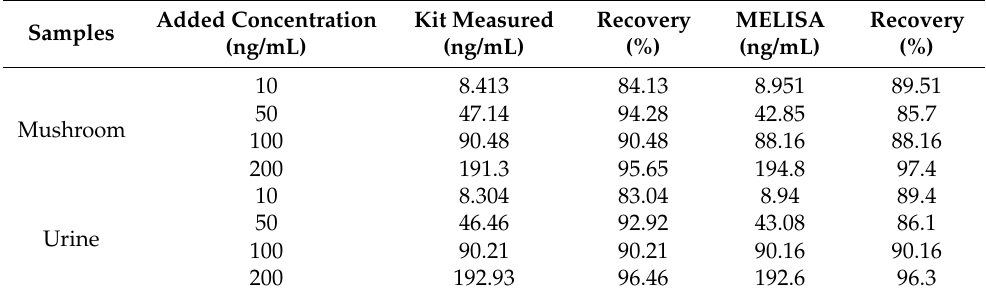
Table 3. The detected concentrations of α -amanitin were compared with the standards added to the actual samples.